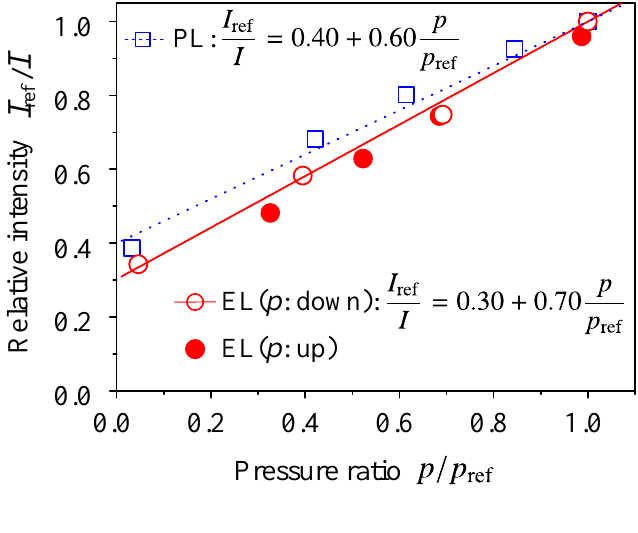
Figure 4. Stern–Volmer plots of electroluminescence (EL) and photoluminescence (PL), where the reference pressure p ref = 101 kPa . The data shown in open circle were obtained first with decreasing pressure, and the data shown in closed circle were obtained with increasing